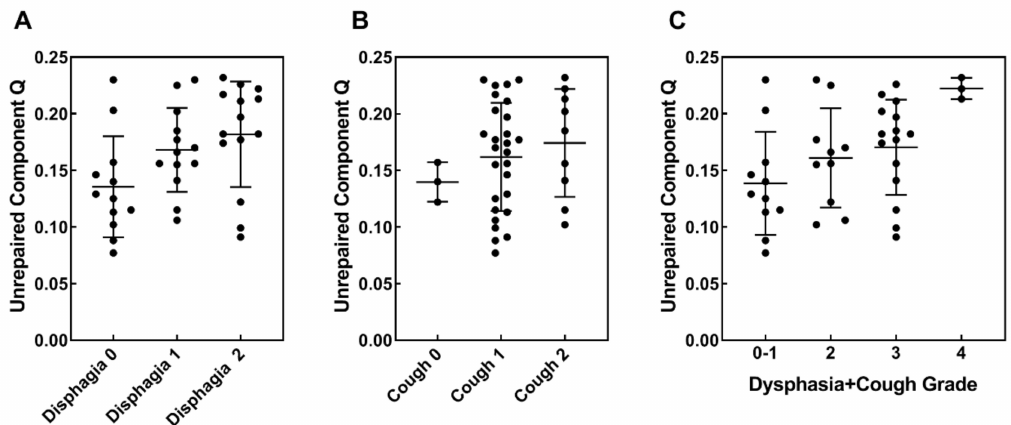
Figure6. Comparisonof Q -valuesinsubgroupsofpatientswithacutenormaltissuetoxicity—Dysphagia and cough. Diagrams show scatter plots of Q -values in subgroups of patients with: ( A ) grades 0, 1 and 2 of dysphagia; ( B ) grades 0, 1 and 2 of cough; ( C ) combined grades of dysphagia and cough. Mean Q -values and their standard deviations for each subgroup are presented in Table